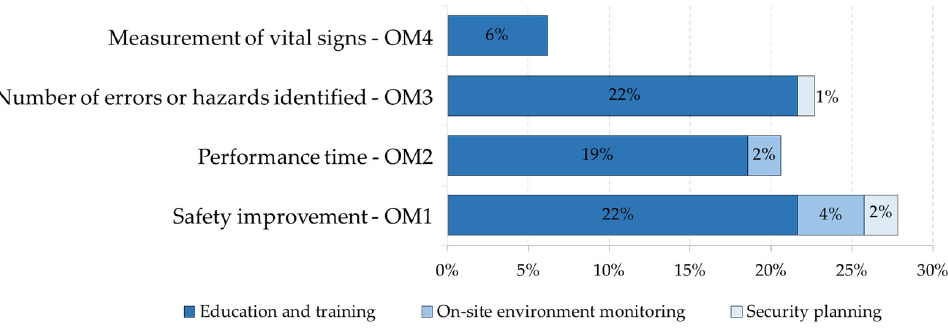
Figure 8. Number of items for each safety-related purpose by type of objective method assessment.